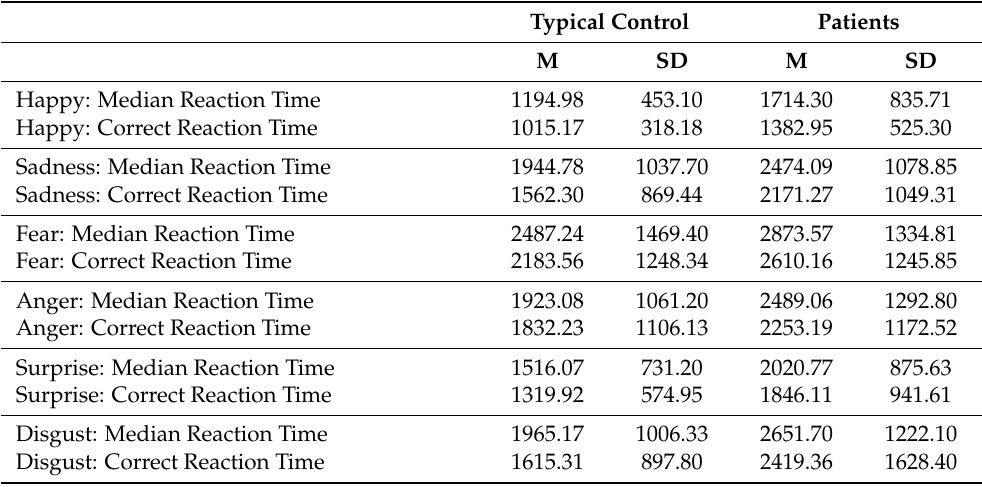
Table 3. Mean (M) and standard deviation (SD) of patients and controls on median reaction time and median correct reaction time in